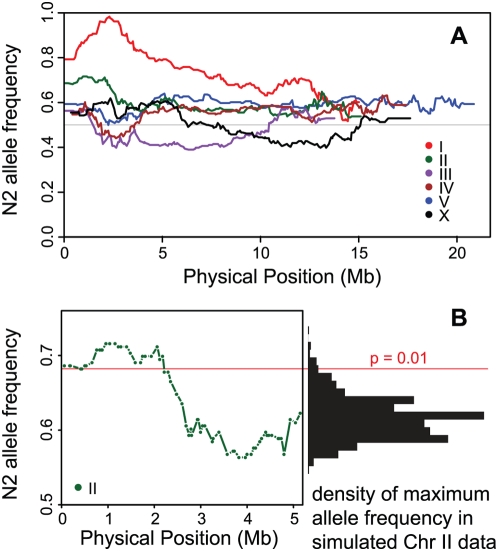
Allele frequencies in the recombinant inbred advanced intercross lines.(A) The frequency of the N2 allele at each marker along the chromosomes. The expected frequency, 0.5, is represented by the gray line. (B) A close view of the allele frequencies on the left side of chromosome II shows a significant skew toward N2 alleles. The histogram on the right represents the maximum allele frequency skew for 1000 simulated chromosome II datasets. The red line represents the p = 0.01 significance threshold from the simulations.